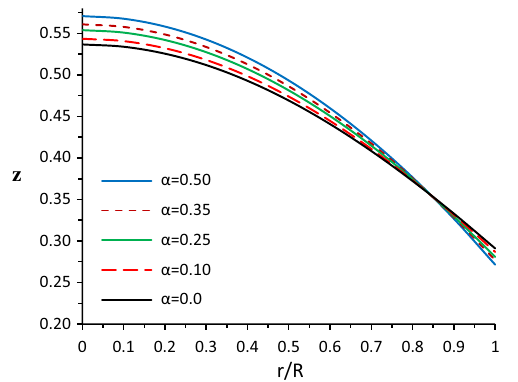
Fig. 7 The behavior of gravitational redshift ( Z ) verses radial coordi- nate r / R . We have used the same data values for plotting of this figure as given in Fig.